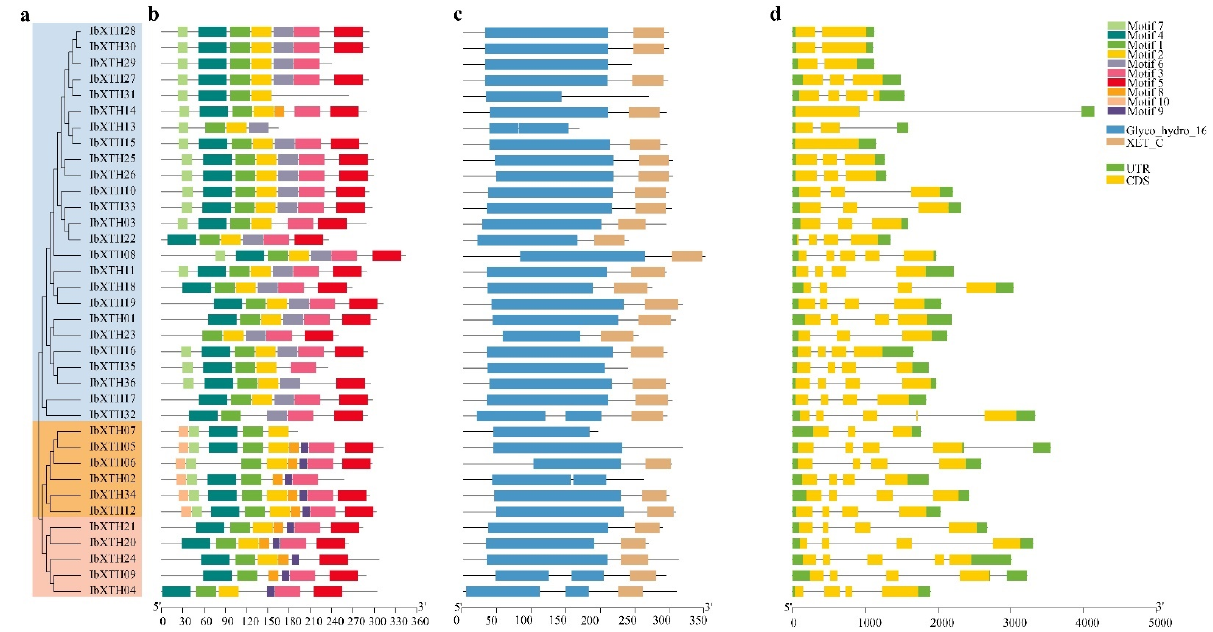
Figure 3. Characterization of the sweet potato XTH genes. ( a ) Phylogenetic tree of sweet potato XTH genes family. Genes from groups III A and IIIB are shown in the orange and pink color, respectively. Subfamily I / II is shown blue. ( b ) Protein conserved motifs constructed by the MEME Boxes with different colors represented different conserved motifs. ( c ) Conserved protein domain.The blue box represents Glyco_hydro_16 domain, while the brown boxes represent XET_C domain ( d ) Gene structures. Yellow boxes represent exons; green boxes indicate the UTRs; and black lines represent introns.